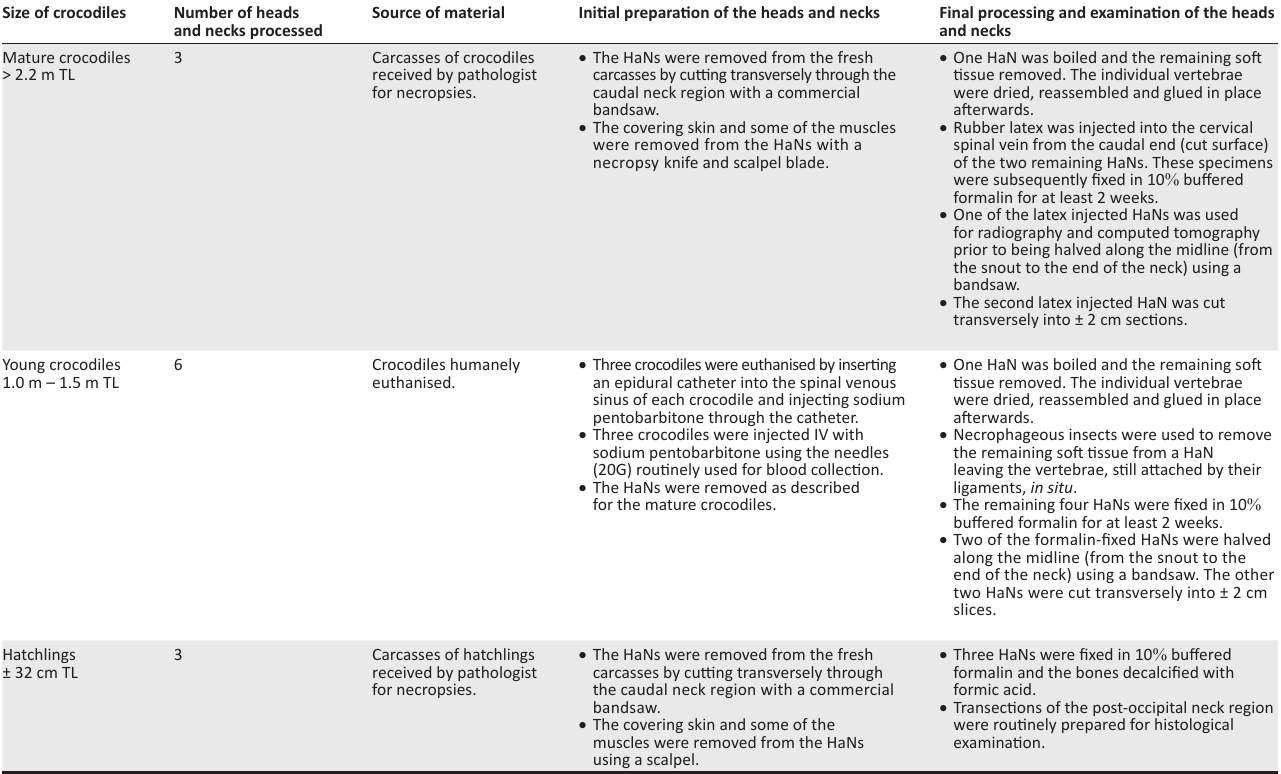
TABLE 1: Summary of the preparation, processing and examination of the crocodilian heads and necks used in the study. Size of crocodiles Number of heads and necks